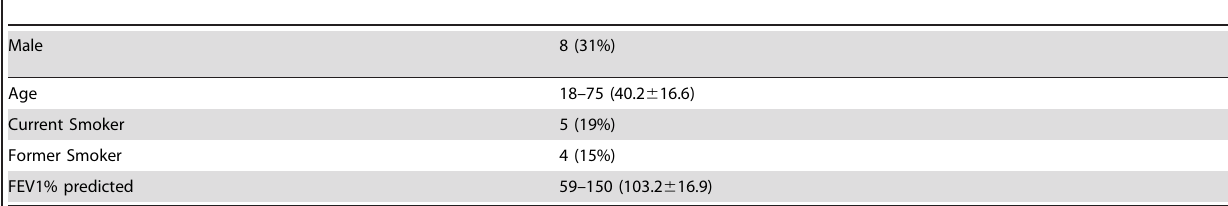
Table 2. Non-transplant Control Subject Characteristics (n